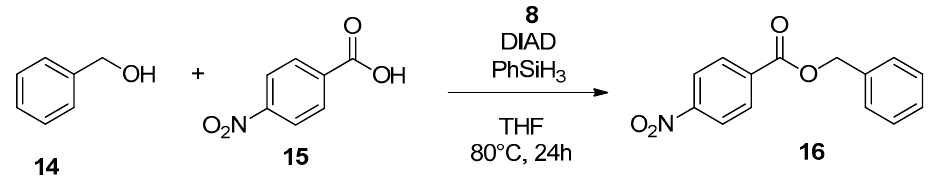
Table 4. Catalytic Mitsunobu reaction: yields of benzoate 16 over the di ff erent cycles.